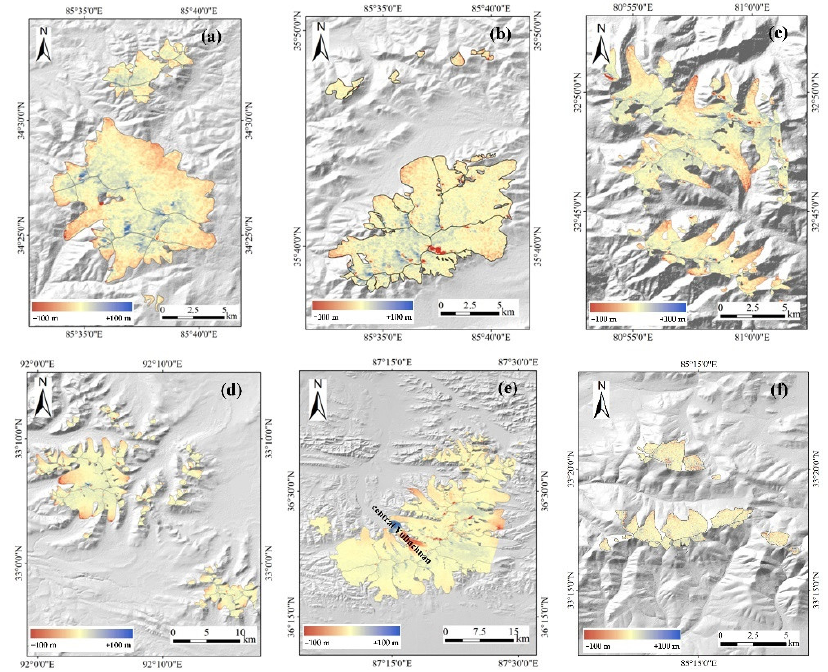
Figure 2. The maps of the observed glacier elevation changes from 2000 to the 2010s over the six study sites with a complete coverage of the SRTM-X DEM (See Figure 1, red rectangle areas). ( a ) Buruogangri Mount; ( b ) Songzhi peak; ( c ) NganglongKangri Mount; ( d ) Dongkemadi Mts.; ( e ) Muztagh peak; ( f ) Unnamed-3 Mts. The central Yulinchuan Glacier experienced a surging event from 2008 to 2009.